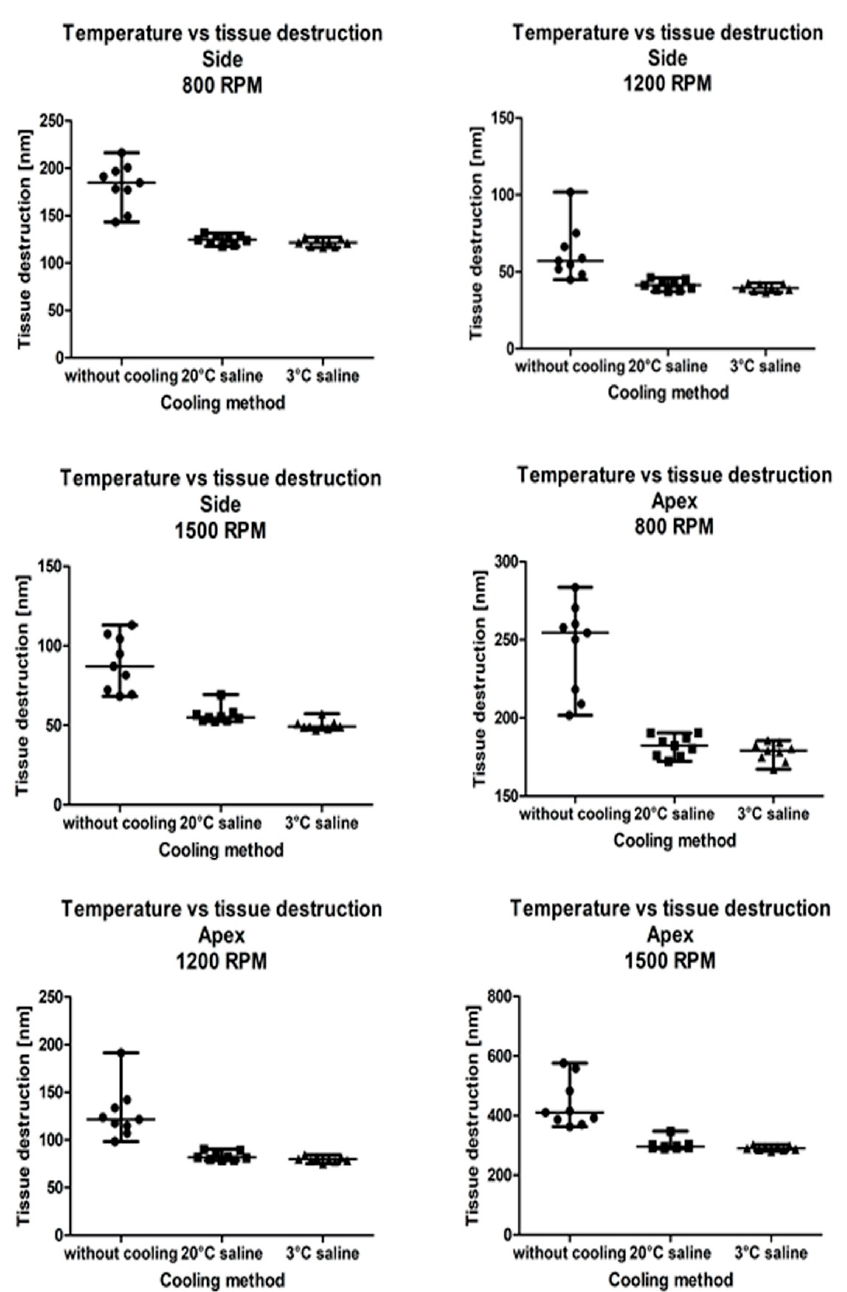
Figure 1. The comparison of bone tissue destruction with regard to the drilling speed and the cooling system. Apex—at apical part of drill; Side—at lateral part of